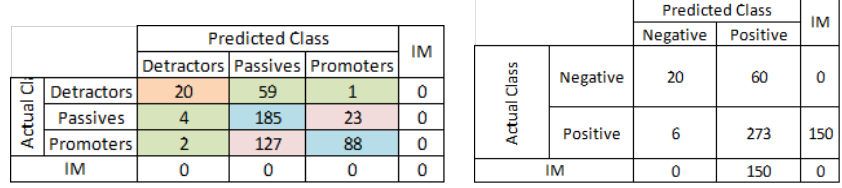
Figure 7. The reduction in the 3 × 3 + IM confusion matrix into a 2 × 2 + IM .